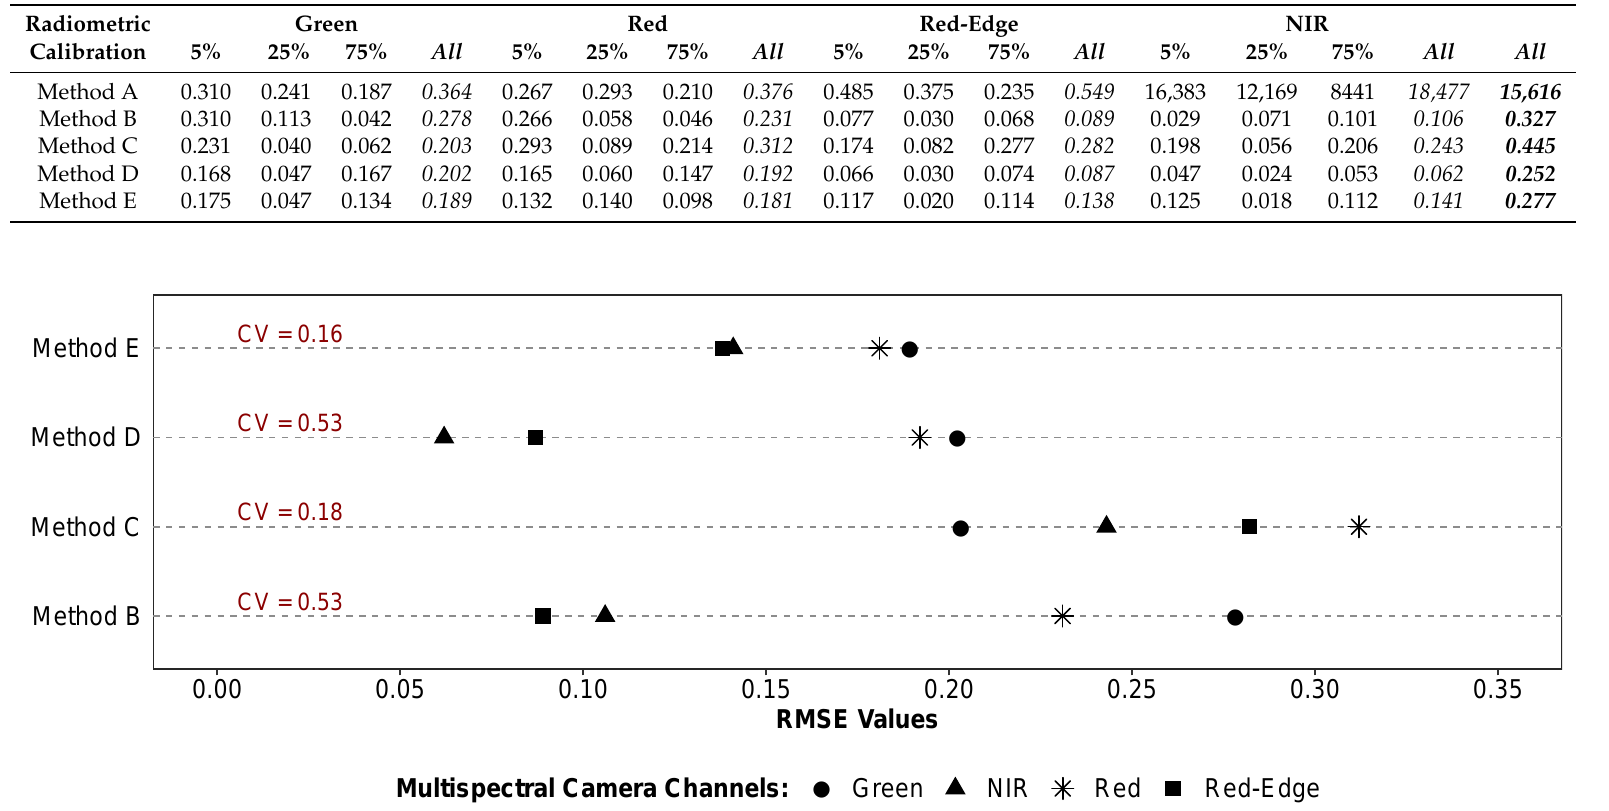
Figure 7. Distribution of root-mean-square error (RMSE) values for each calibration method and multispectral band and associated coefficients of variation